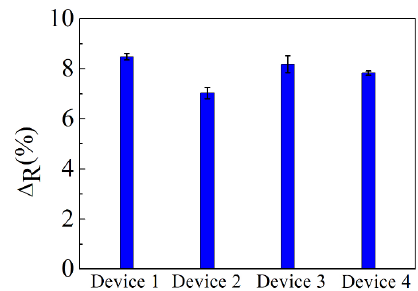
Figure 7. Percentage changes in resistance produced by a solution of 0.01 ng/mL of rCV-N, for four different ISFET devices. The error bars are the standard deviation of the measurements.